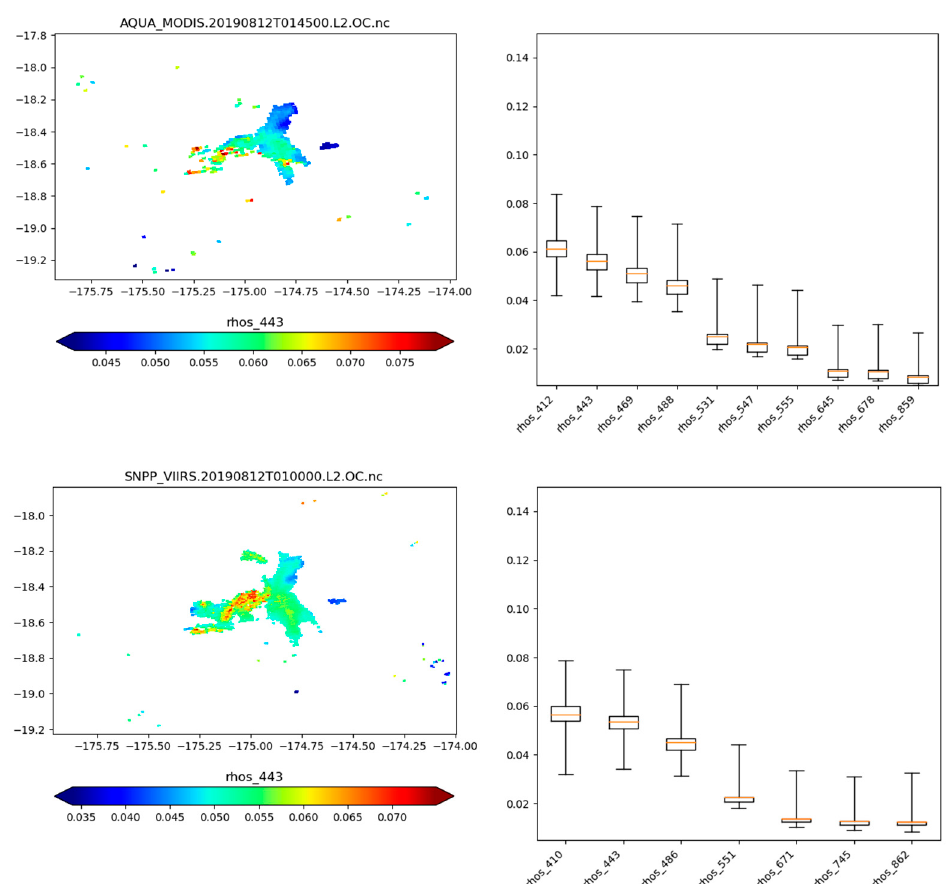
Figure 2. Left: Blue (443 nm) satellite reflectance ρ (rhos, quasi-surface reflectance) of MODIS and VIIRS for the 12 August 2019 discolored waters made from a threshold on the backscattering coefficient > 0.0032 m − 1 ) mask on L2 MODIS (top) and VIIRS (bottom) data. Right: Satellite reflectance data ρ (rhos) at different wavelengths under the mask “discolored waters”. The backscattering coefficient “bb p _giop at 443 nm” threshold was defined from the pixels under this rhos mask.